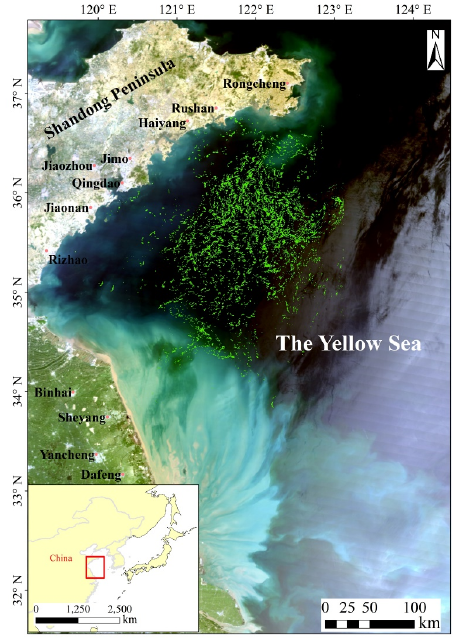
Figure 1. The study area. The background image is MODIS true color image on 6 May 2009, in which the green slicks show the U.prolifera macroalgae bloom in 2009.